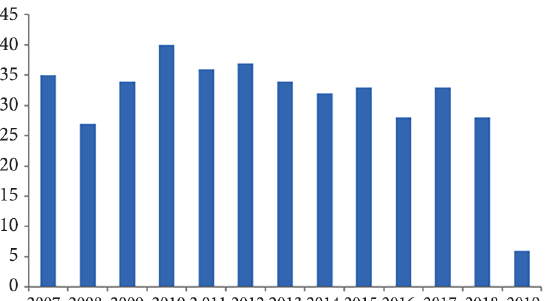
Figure 2. Distributions of the JEELM publications by